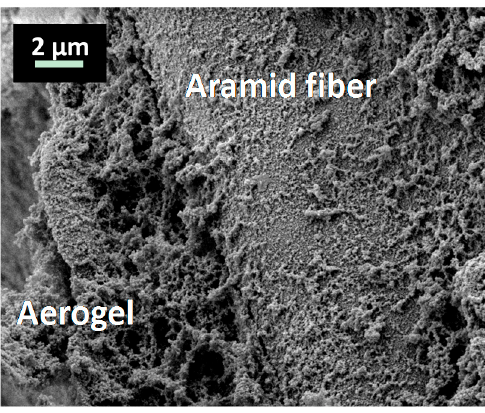
Figure 11. Adhesion of SA2 aerogel particles on aramid fiber (magnification 4.0k×).